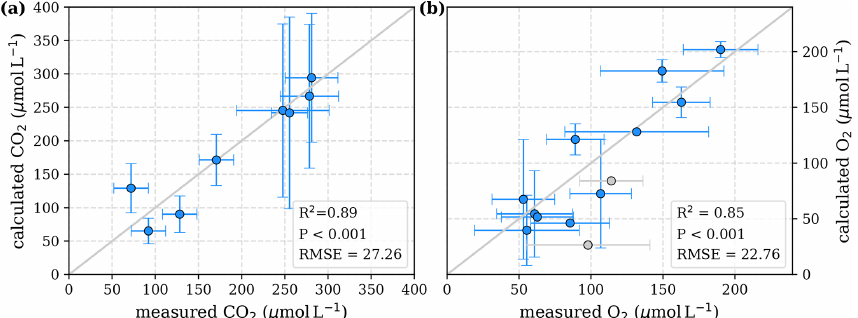
Figure 4. Correlation between measured and calculated concentrations of (a) CO 2 and (b) O 2 . Grey lines indicate the 1 : 1 line. Calculations were performed based on the equations in Table 2 which represent exponential pH limitation of decomposition rates. Each data point represents one river. Grey data points are excluded from the correlation since the data for these rivers are based on fewer than three campaigns within the same season. This includes the Simunjan campaigns with high carbon concentrations, which are excluded here due to figure scaling and further discussed in Appendix